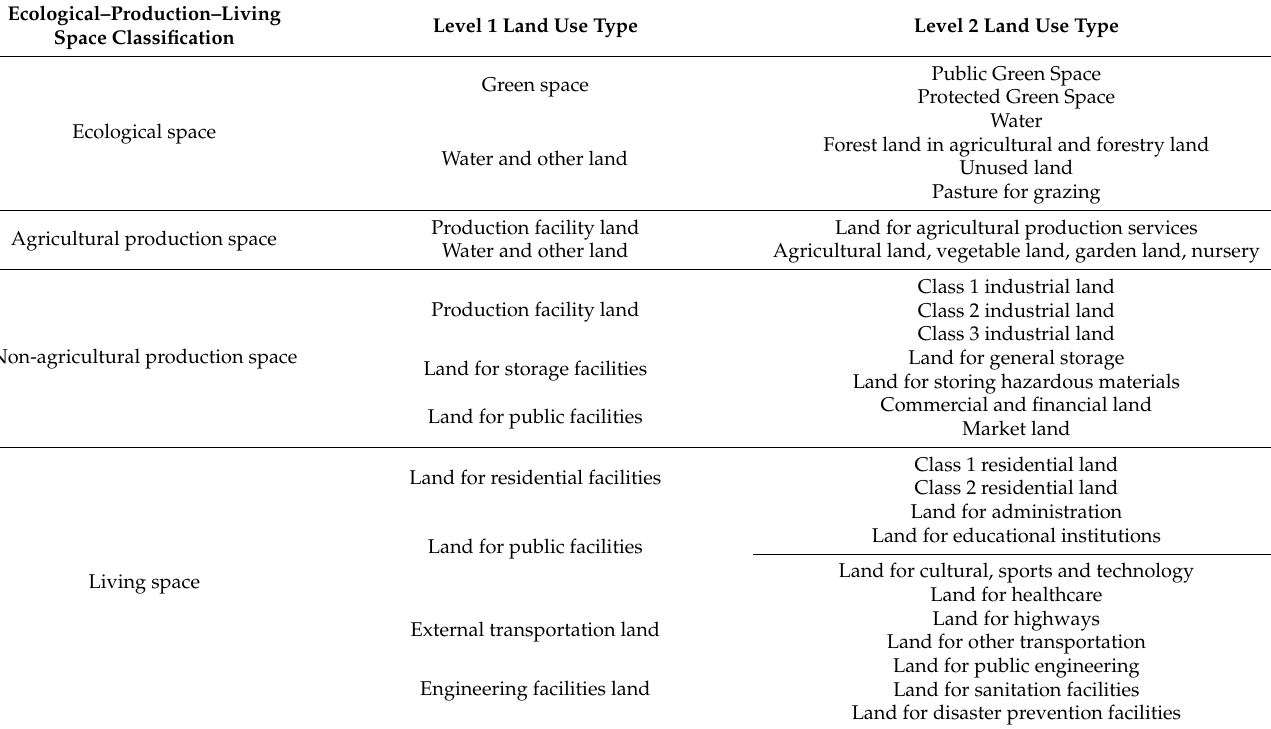
Table 1. EPL spatial classification